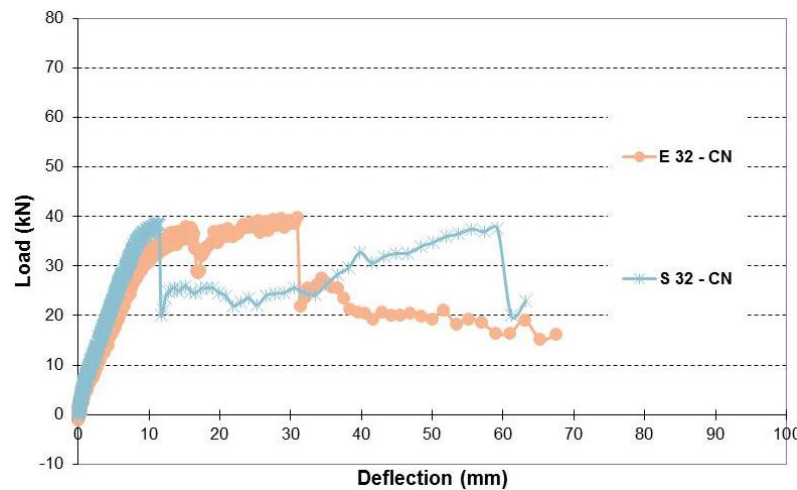
Figure 16. Load-deflection of beams with 32% corrosion levels (No repair).